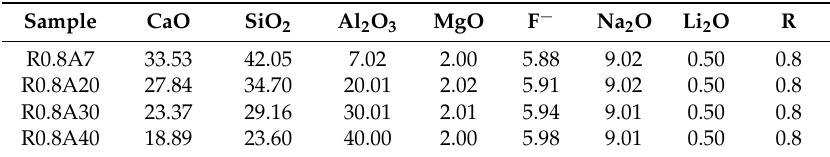
Table 1. The chemical compositions of mold fluxes with different amounts of Al 2 O 3 after pre-melted (in Mass Pct wt.